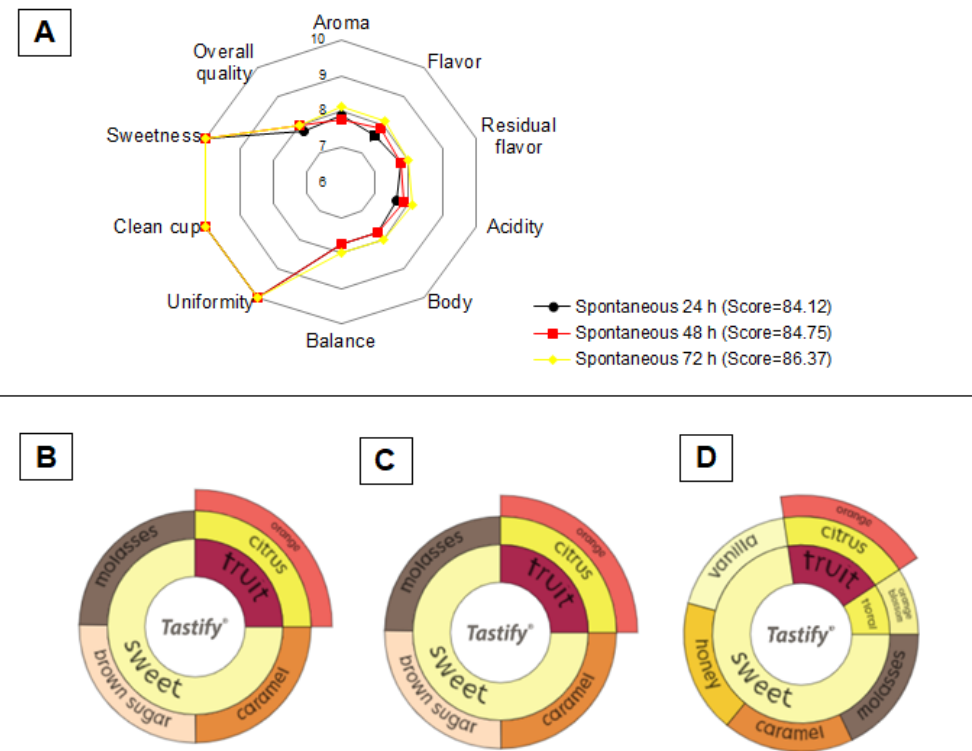
Figure 6. Sensorial evaluation of beverages produced with roasted coffee beans. Final score of the processed coffees for different times ( A ) and description of the sensorial attributes of the fermented coffees for 24 h ( B ), 48 h ( C ), and 72 h ( D ).